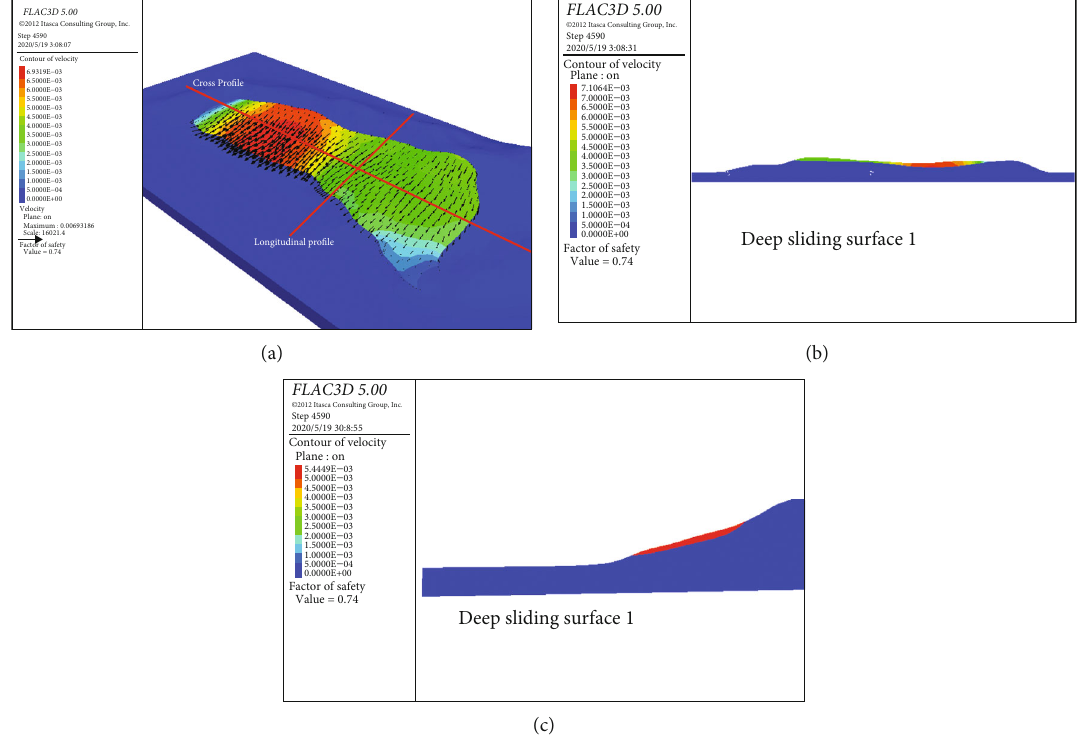
Figure 11: (a) Stability calculation results of deep sliding surface 1 (I-IV) under seismic conditions. (b) Stability calculation results of deep sliding surface 1 (I-IV) under seismic conditions (crosspro fi le). (c) Stability calculation results of deep sliding surface 1 (I-IV) under seismic conditions (longitudinal pro fi